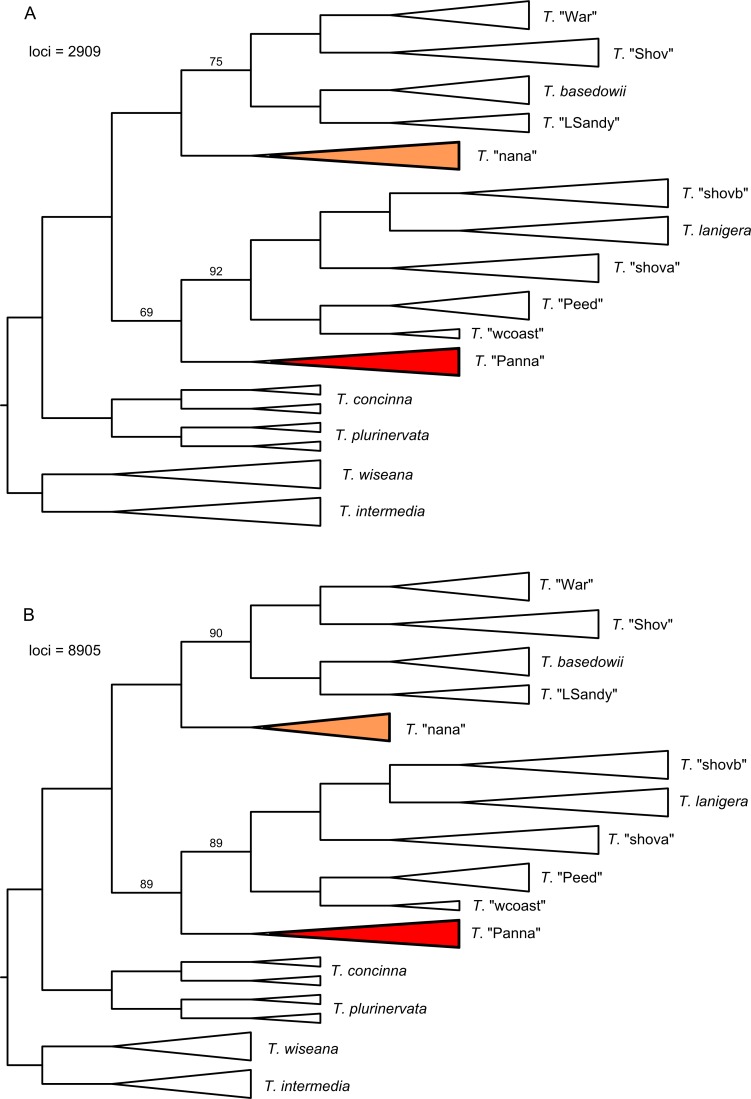
ASTRID trees for the combined data set and two assemblies.A) 0.88/0.91 (merged/unmerged) clustering threshold, 50% minimum taxon coverage; B) 0.88/0.82 clustering threshold, 25% minimum taxon coverage. Support values from 100 multi-locus bootstrap replicates are only shown for branches with <100% support. Branch lengths are meaningless.